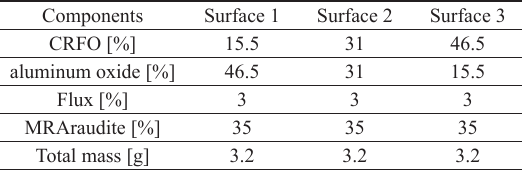
Table 1. Composition of selective surfaces obtained in percentage